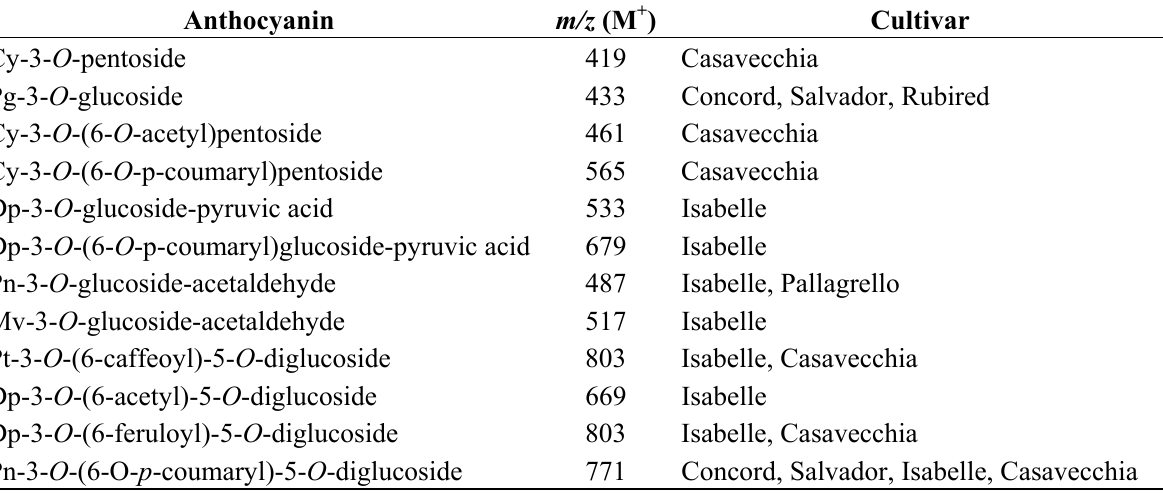
Table 2. Monomer anthocyanins identified in skin extract or juice of different grape cultivars [48,55]. Pg, pelargonidin; Dp, delphinidin; Cy, cyanidin; Pt, petunidin; Pn, peonidin; Mv,